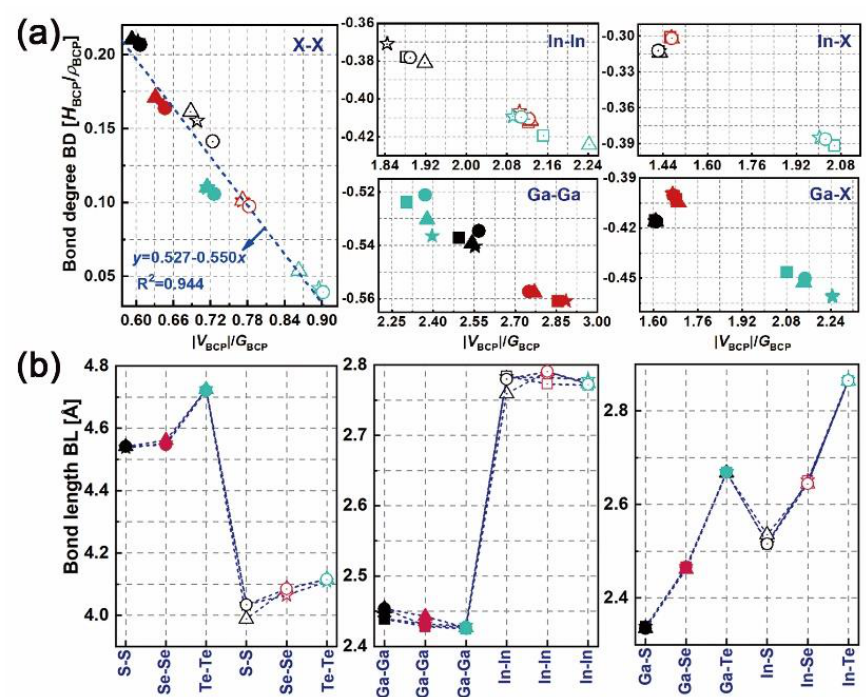
Figure 3. Bond degrees vs. the | V BCP |/ G BCP ratio: ( a ) and bond lengths, ( b ) of M–X ( ② , ④ and ⑧ in Figure 1a, M–M ( ① , ⑥ and ⑩ in Figure 1a and X–X ( ③ and ⑦ in Figure 1a bonds in bulk and layered [MX] n . Symbols used in plots, solid: GaX, hollow: InX; black, red and teal colors: X = S, Se and Te; squares, triangles, circles and stars: n = 1, 2, 3 and bulk.